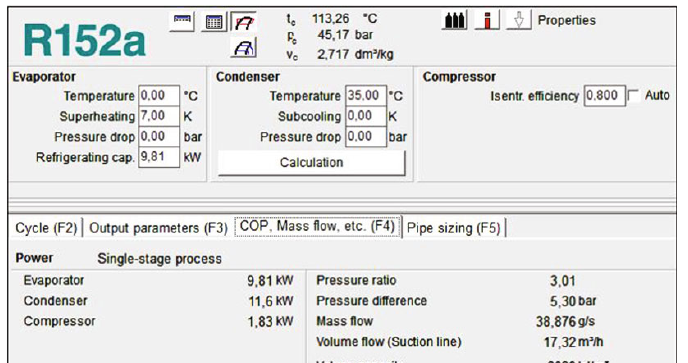
Figure 10: Simulation details on the optimized refrigerant gas R152a from SOLKANE